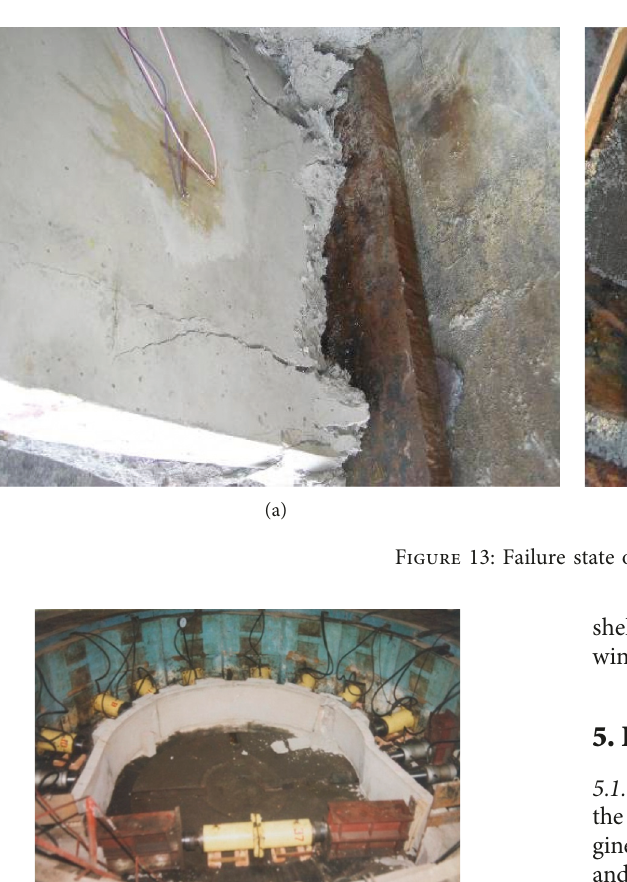
Figure 14: Set up used to test the bearing capacity of the whole supporting